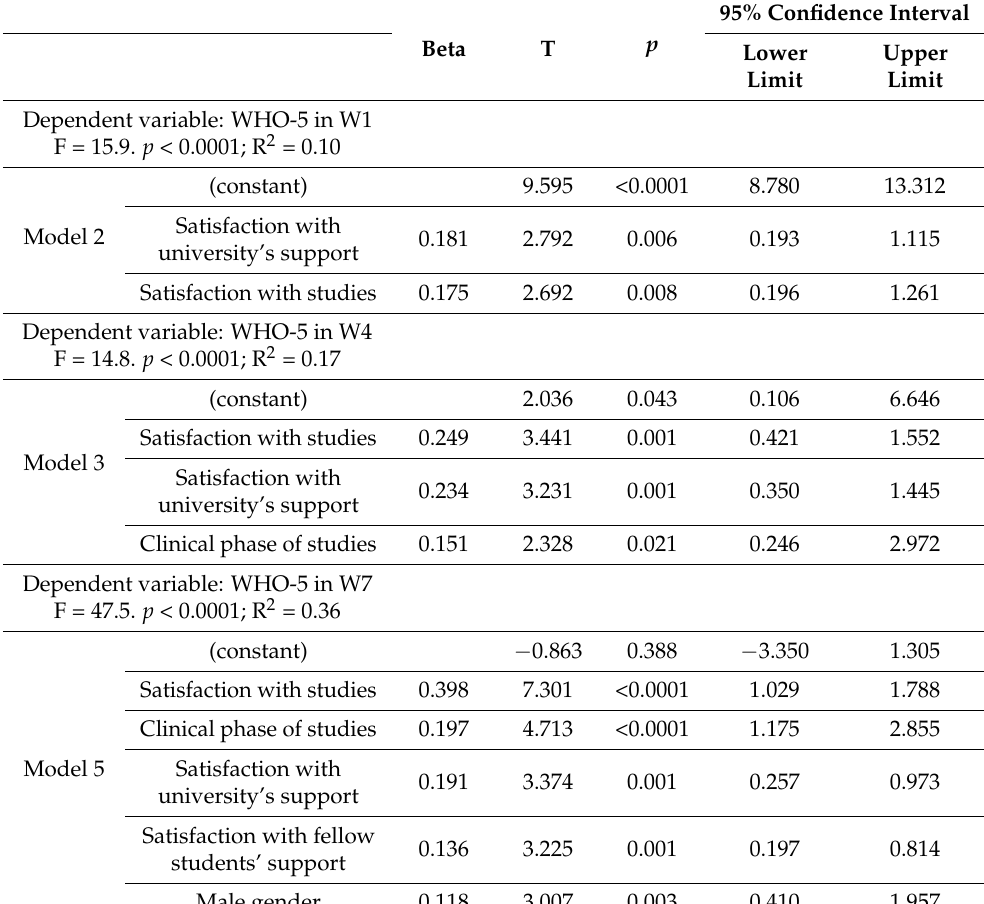
Table 5. Predictors of students’ wellbeing (stepwise regression